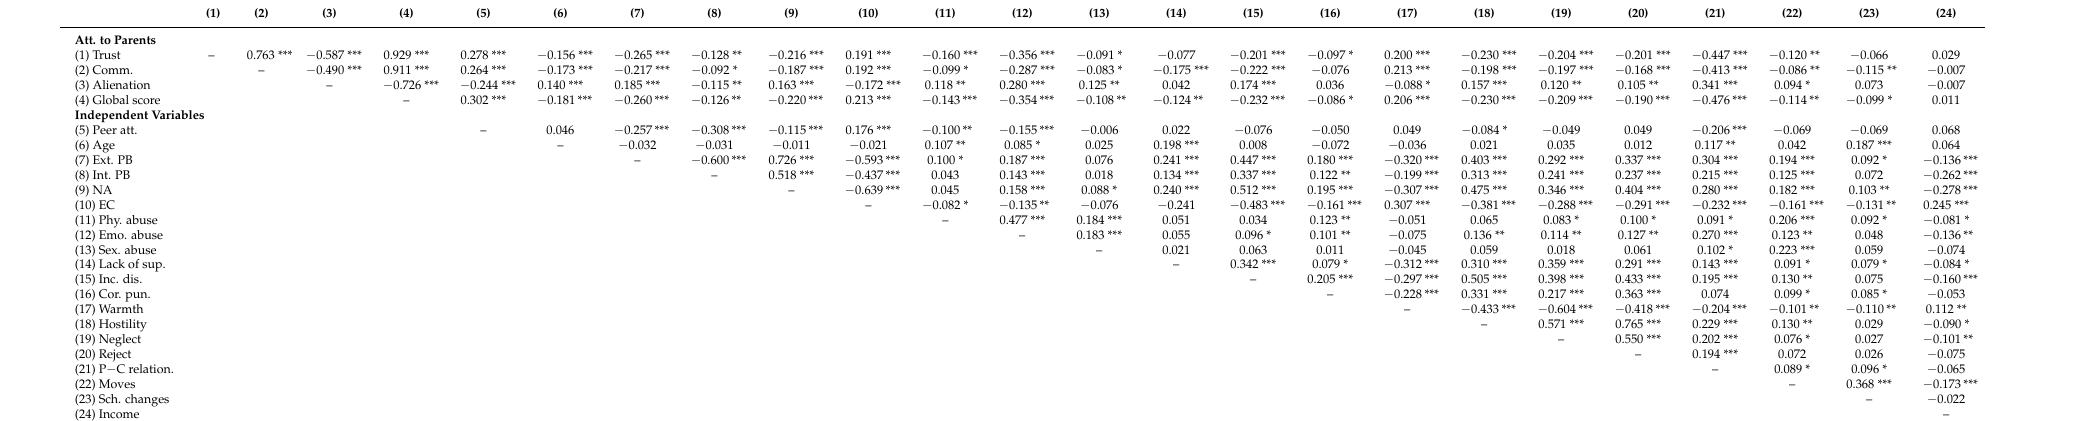
Table A1. Correlations between study